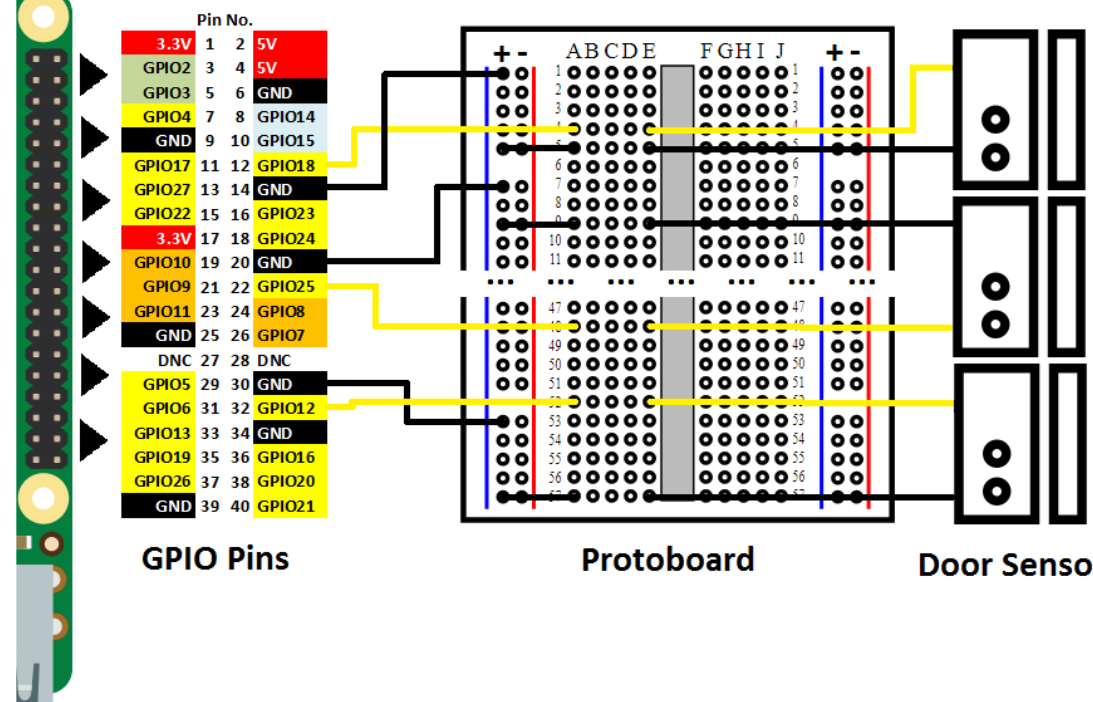
Figure 3. Schematic design of the smart cupboard. GPIO: general-purpose